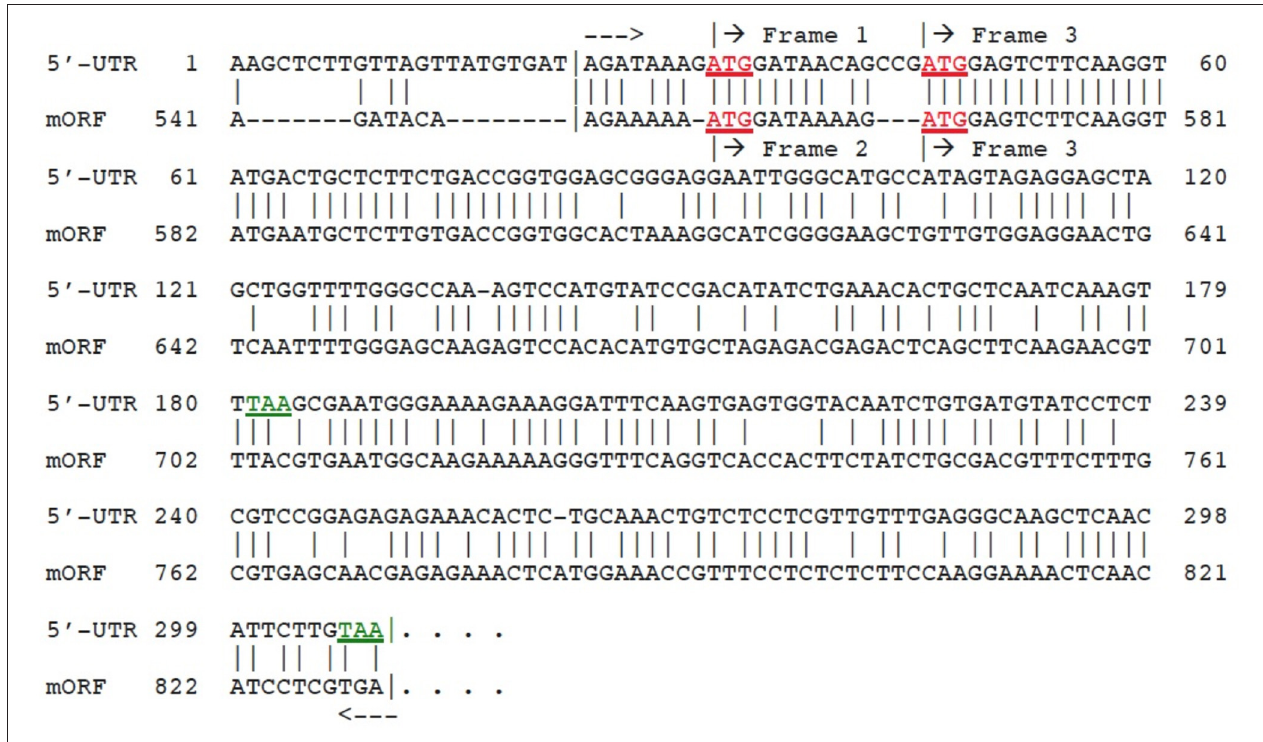
FIGURE 5 | Alignment of 5 ′ -UTR from AT2G29290 (gene 9) with its own mORF. The region of close similarity between the two sequences is bracketed between dashed arrows. Matches are indicated by vertical lines. Start codons (ATG) are indicated in red (underlined), and stop codons (TAA) for the first two ORFs in green. Reading frames as shown by translation analysis are labeled. The region within the brackets in the alignment shows 69% identity between the two sequences. Amino acid sequence predicted to be encoded by 5 ′ -UTR ORF is given in Supplementary Dataset